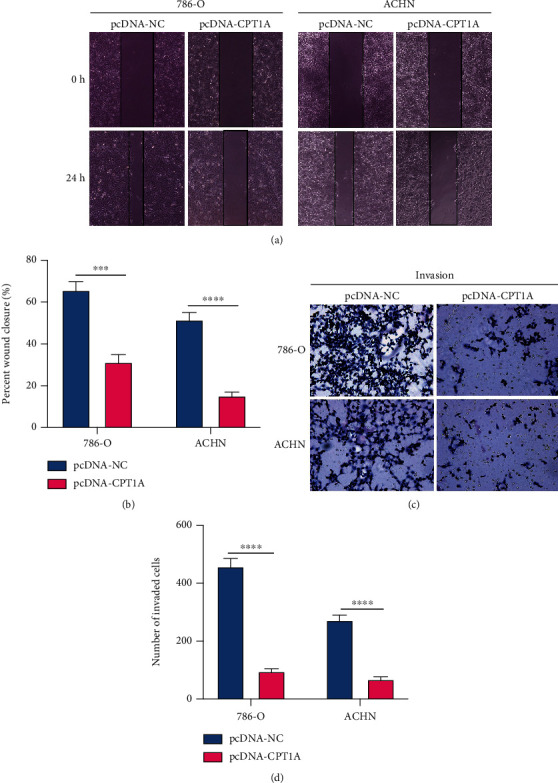
Wound healing and cell invasion experiment. (a, b) Images from the wound healing experiments in 786-O and ACHN cell lines after plasmid transfection and the histogram obtained upon the analysis of the results. (c, d) Images of the Transwell invasion experiment of the two cell lines and the histogram obtained upon the analysis of the results. ∗∗∗P < 0.001; ∗∗∗∗P < 0.0001.